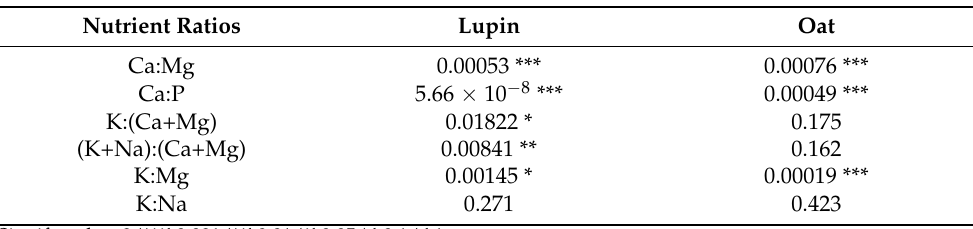
Figure 3. The effect of treating the soil with two amendments on values Ca:Mg, Ca:P, K:(Ca+Mg), (K+Na):(Ca+Mg), K:Mg and K:Na ratios in lupine grown on soils: T0—control soil, TI—soil with compost addition and TII—soil with FA addition. Blue lines denote recommended optimal values of nutrient ratios [8,22]. Table 3. p -values from one-way ANOVA determined separately for each nutrient ratios in lupine and oat. Comparison between T0, TI and